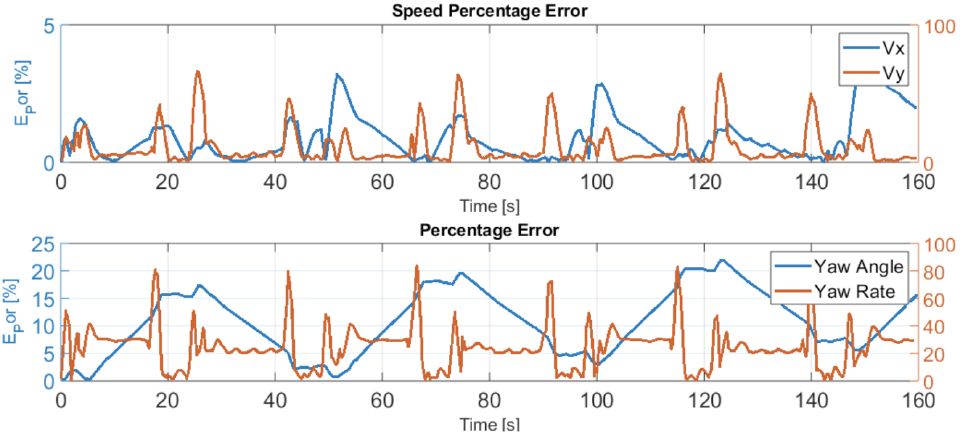
Figure 15. Static speed profile results (error